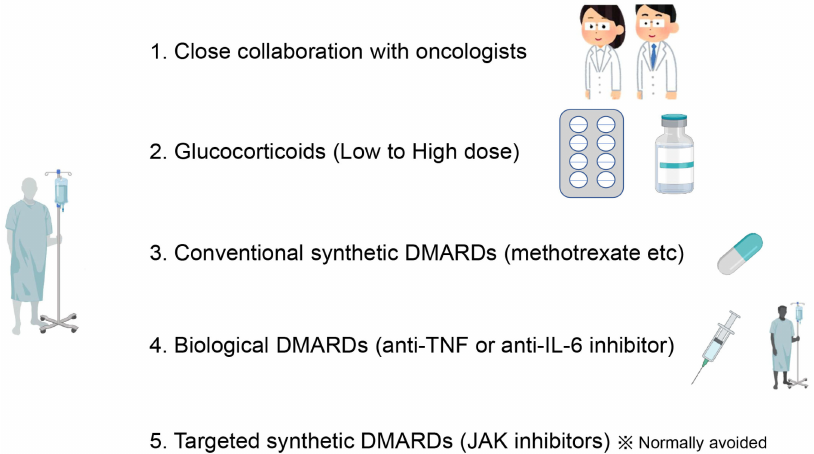
Figure 3. General management of rheumatic immune-related adverse events (irAEs) due to cancer immunotherapy. Consultation with oncologists is required to decide whether to continue or terminate immune checkpoint inhibitors. If patients are refractory to nonsteroidal anti-inflammatory drugs, systemic glucocorticoids should be considered. Based on the severity, conventional synthetic disease- modifying antirheumatic drugs (DMARDs) and biological DMARDs, such as anti-tumor necrosis factor (TNF) or interleukin (IL)-6 inhibitor, should be considered. Targeted synthetic DMARDs, such as Janus kinase (JAK) inhibitors, are normally avoided because of the risk of exacerbating